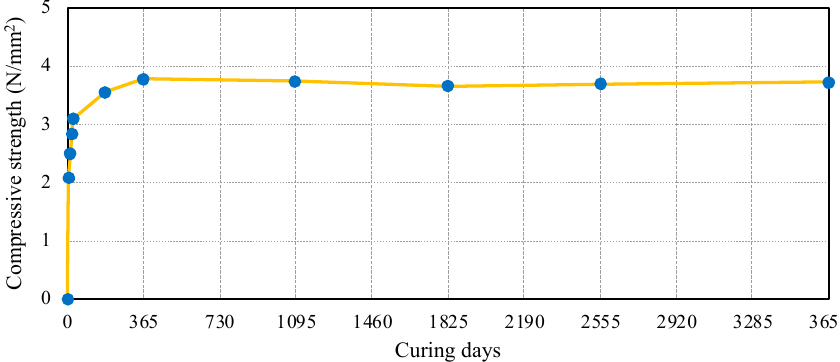
Figure 4. Time ‐ series compressive strength of the granulated blast ‐ furnace slag (GBFS). Figure 4. Time-series compressive strength of the granulated blast-furnace slag (GBFS).